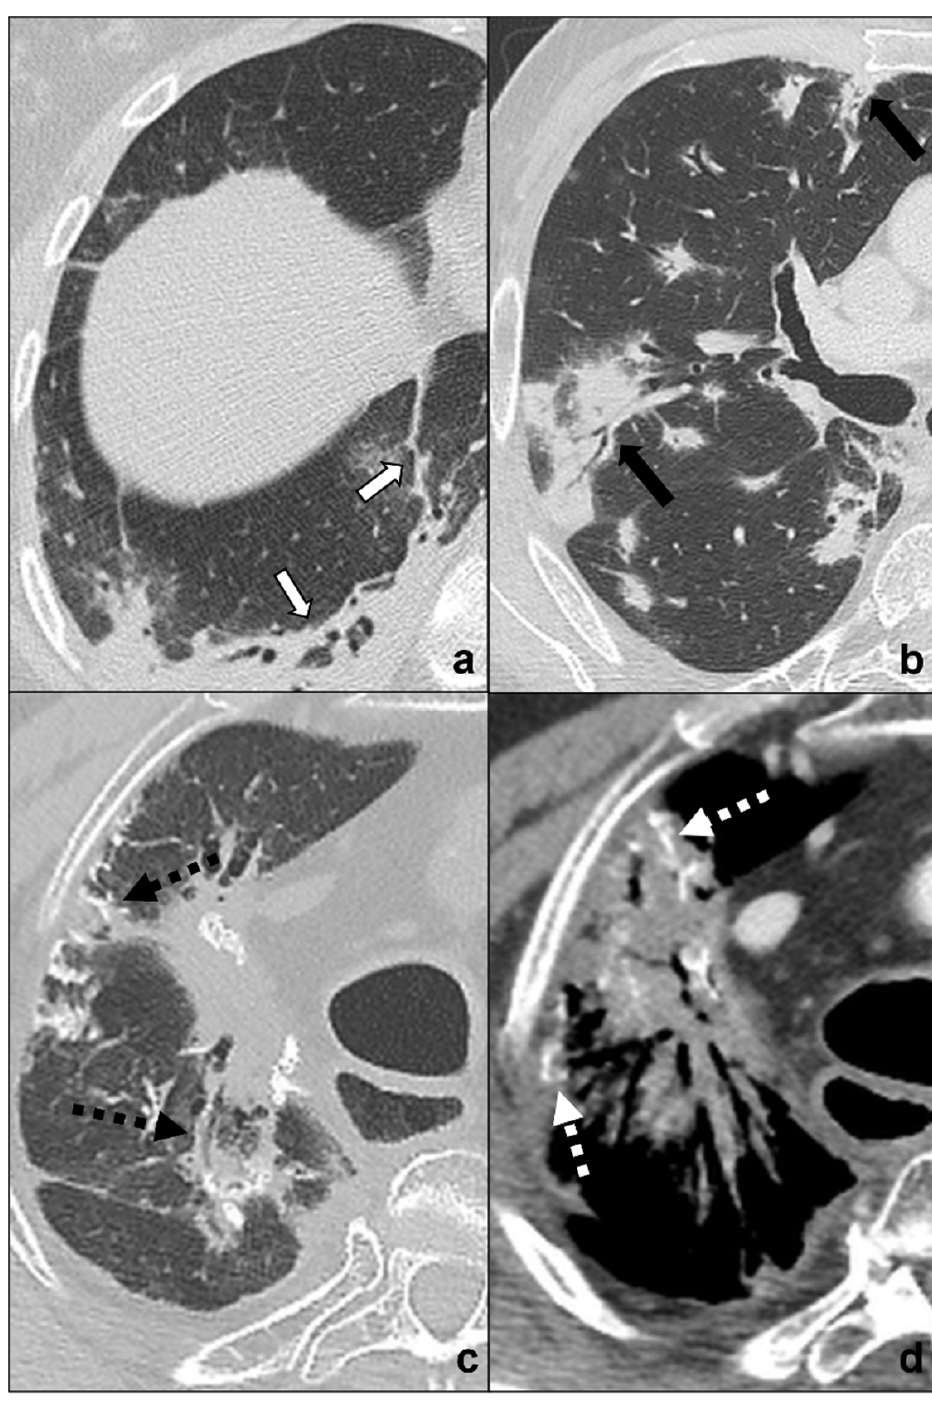
Figure 6. ( a – d ) Chest CTs showing differential diagnoses of COVID-19 pneumonia stage 4/absorption phase characterized by parenchymal bands (black-bordered white arrows in ( a ). Differential diagnoses generally include chemotherapy-induced lung disease ( b ) and radiation-induced lung disease ( c , d ). In ( b ), HRTC of a patient presenting with OP showing pulmonary parenchymal ill-defined bands and consolidations during a chemotherapy cycle (black arrows in ( b )); in ( c , d ), chest CT of a patient who underwent radiotherapy for an apical lung cancer, showing an extensive mass with irregular margins, pleural and mediastinal retraction striae (black dotted arrow) and with some calcification within (dotted white arrows) in the field of radiation. Lungs: mean window with 1500 HU; mean window level − 600. Mediastinum: mean window with 350 HU; mean window level 50 HU.